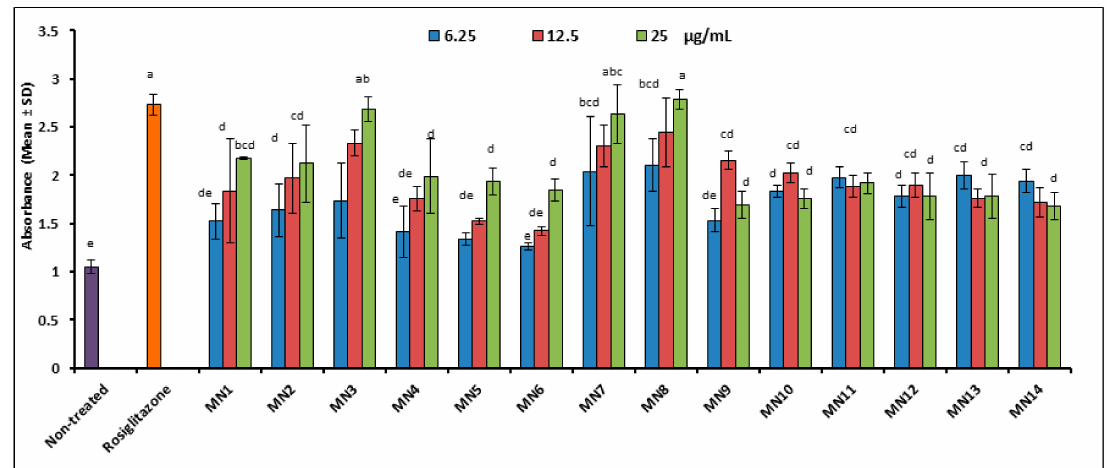
Figure 6. Quantification of lipid droplet after treatment. Small letters represent Tukey’s test. Mean ± S.D., n = 3, means values that do not share a letter are significantly different ( p < 0.05).